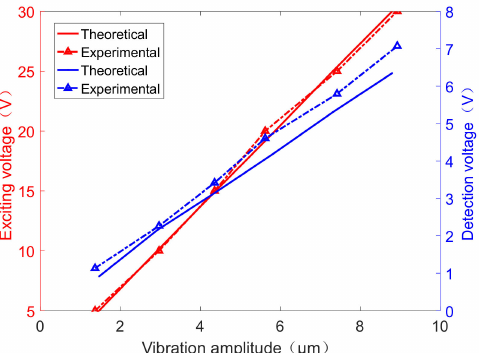
Figure9. Therelationshipofthevibrationamplitudebetweentheexcitingvoltage(red)andthedetection voltage